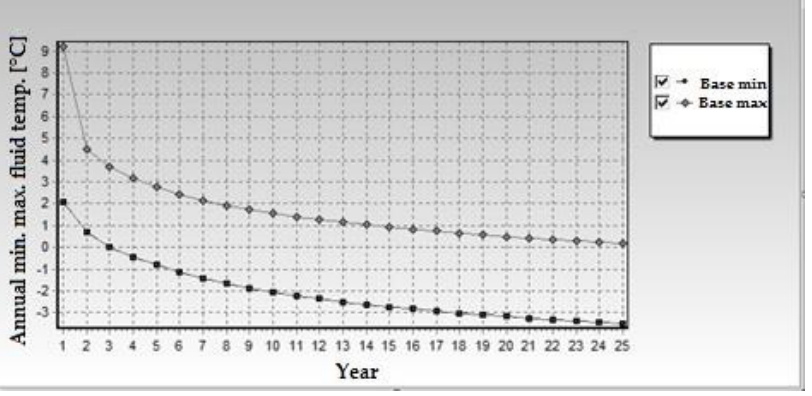
Figure 10. Temperature progression over 25 years under Scenario 3 (calculated by